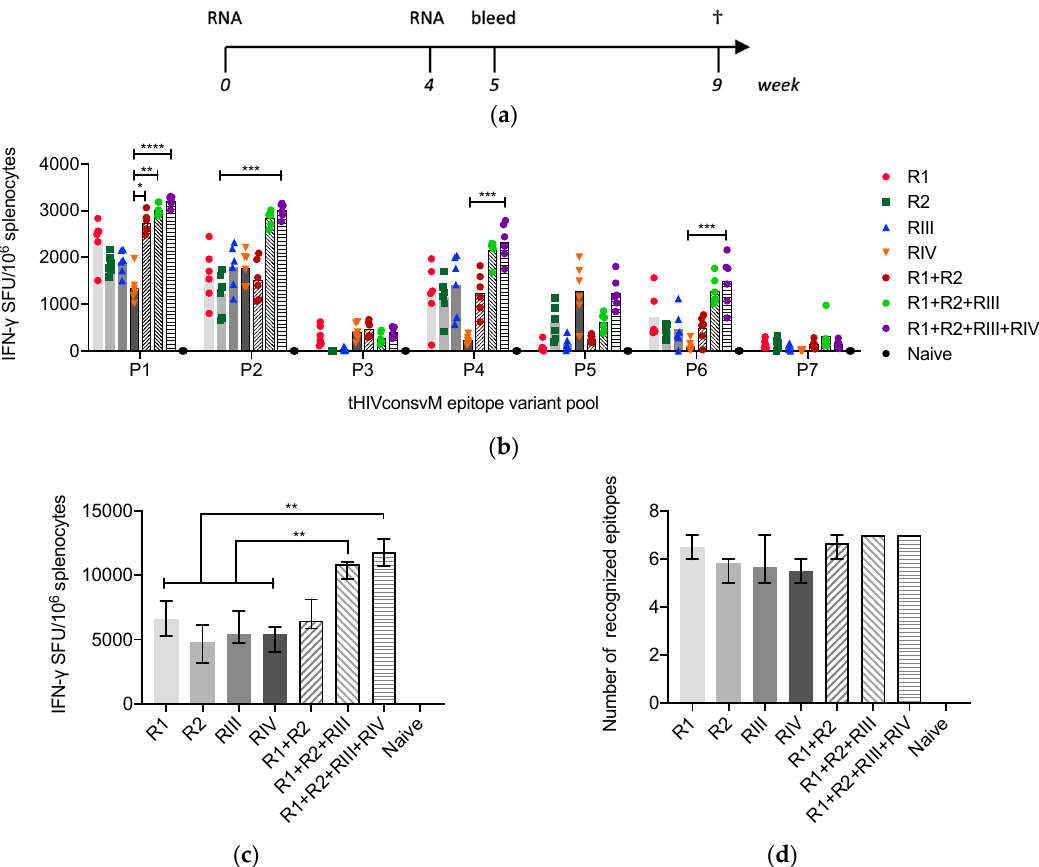
Figure 2. Frequency and breadth of CD8 + T cells induced by mRNA. ( a ) Groups of BALB/cJ mice received two intramuscular injections of mRNA as monovalent (R1, R2, RIII or RIV) and multivalent (R1 + R2, R1 + R2 + III or R1 + R2 + RIII + RIV) vaccines at weeks 0 and 4, and were culled at week 9 ( †) . Each mRNA dose was administered intramuscularly at a 3 μ g dose resulting in a total of 6-, 9-